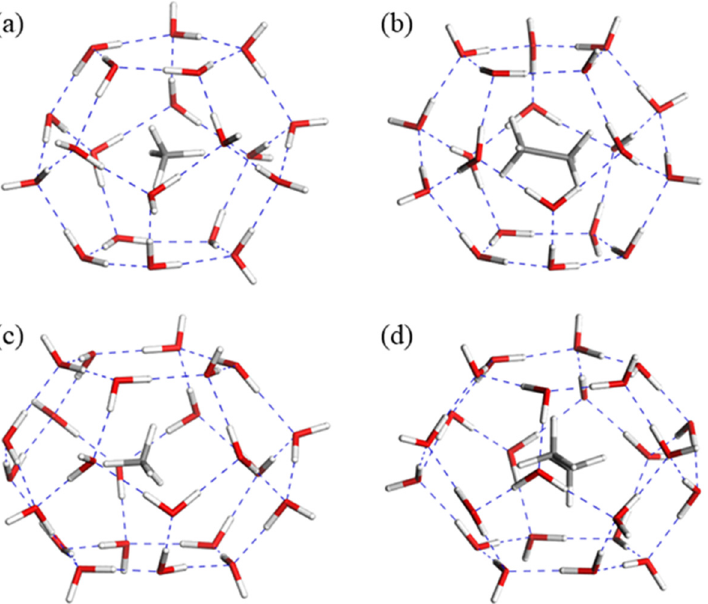
Figure 1. The structural configuration of small (5 12 ) cages with ( a ) methane and ( b ) ethane, and large (5 12 6 2 ) cages with ( c ) methane and ( d ) ethane.